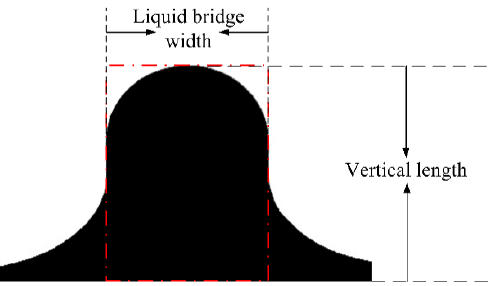
Figure 5. Schematic illustration of typical parameters of the droplet